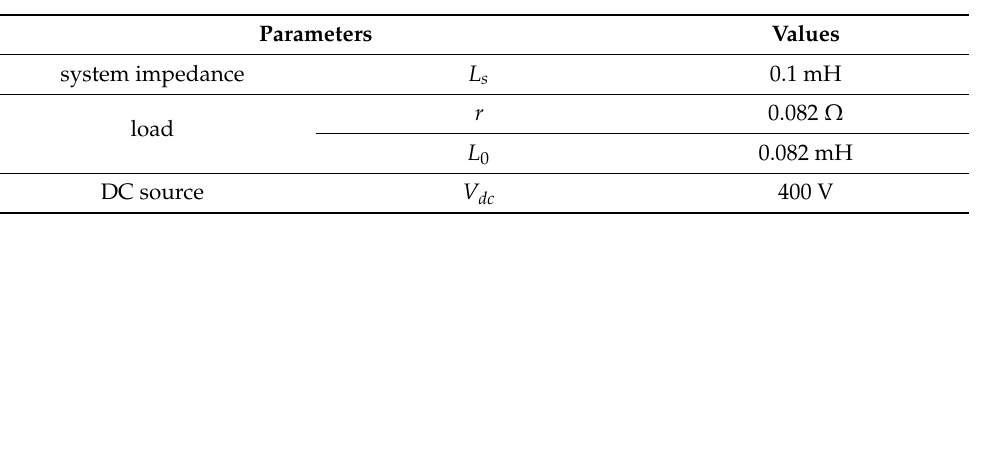
Figure 8. Simulation and experimental set up on PSCAD. Table 1. Main parameters for simplified power electronics-based AC power system.